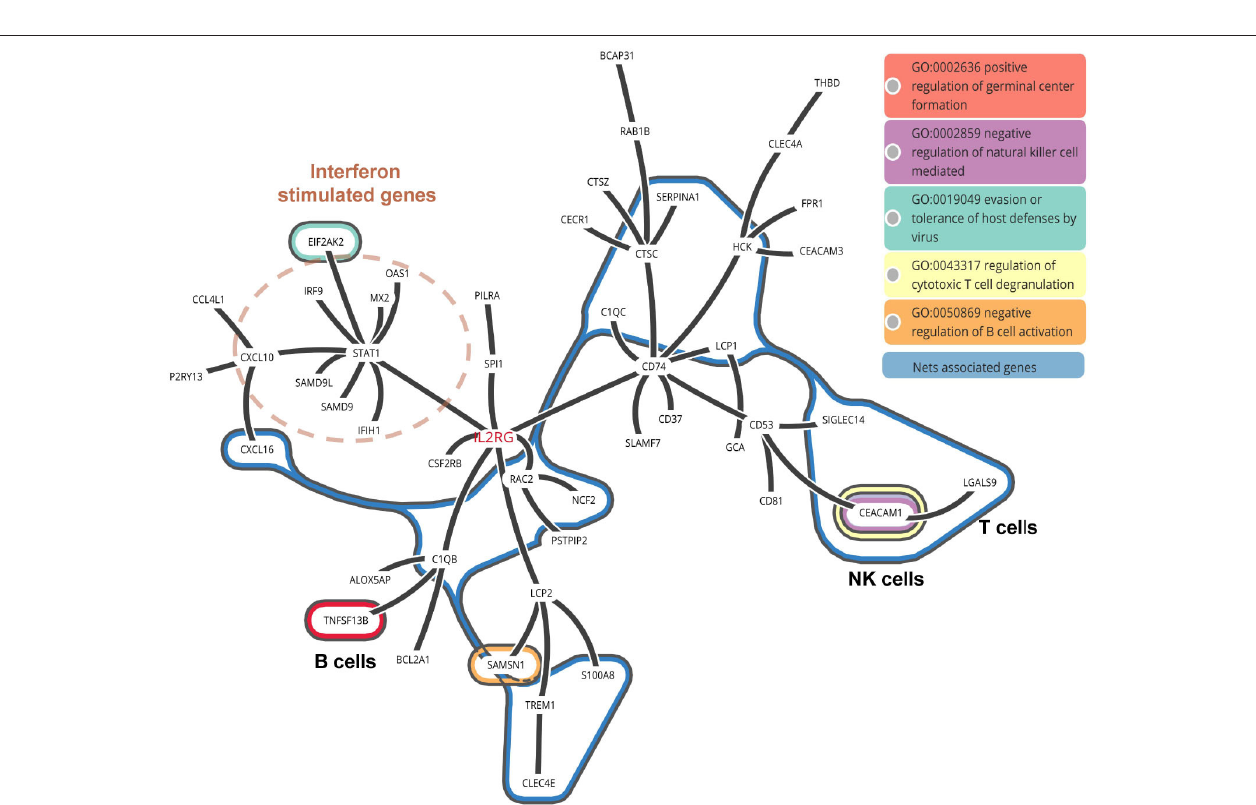
FIGURE 6 | PPI network of NETs associated genes in COVID-19 patients. The interaction between NETs associated genes with other neutrophil activated genes.